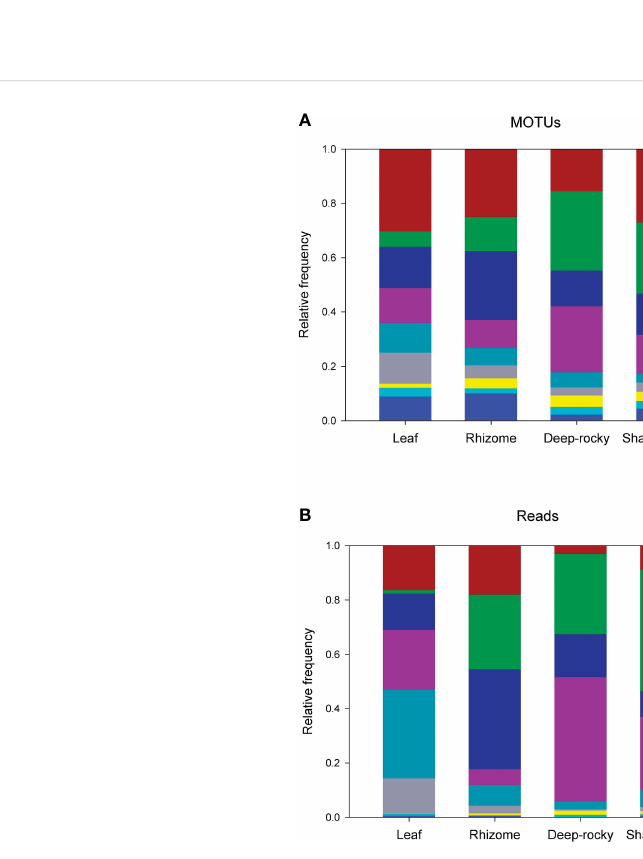
FIGURE 2 (A) , proportion of the assigned MOTUs that belong to the main metazoan phyla found; (B) , proportion of reads represented by these